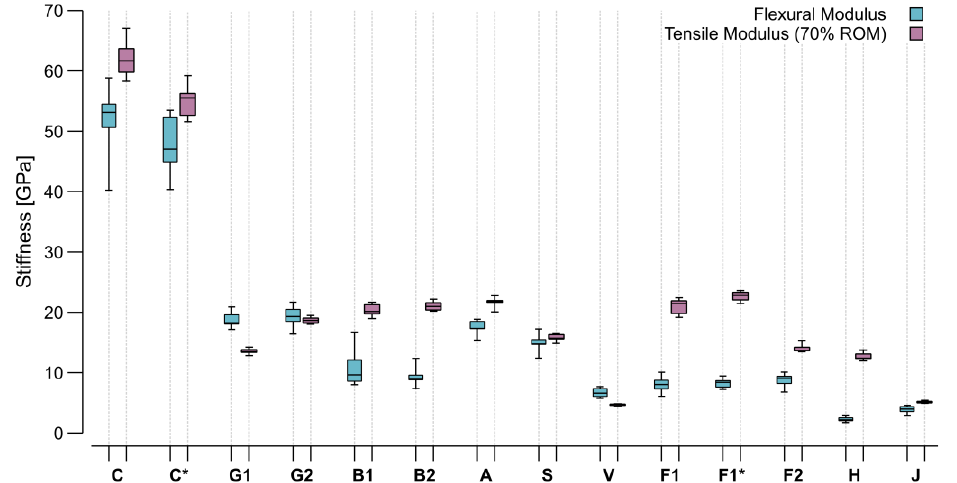
Figure 13. Comparison of the flexural modulus obtained from the four-point bending test and 70% of the tensile modulus calculated by the rule of mixture (ROM). The whiskers of the boxplots represent the min/max range. C — carbon, C* — carbon with petroleum-based resin, G1 — E-glass, G2 —